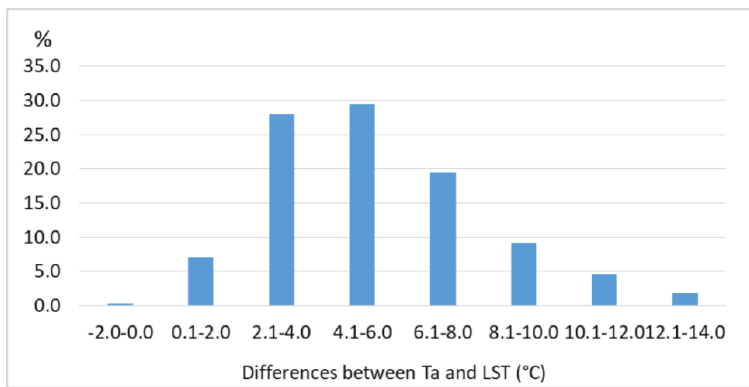
Figure 12. Frequency of the differences between Ta and the corresponding Landsat 8 LST values retrieved over the pixels containing the Bucharest weather stations (2013–2018).